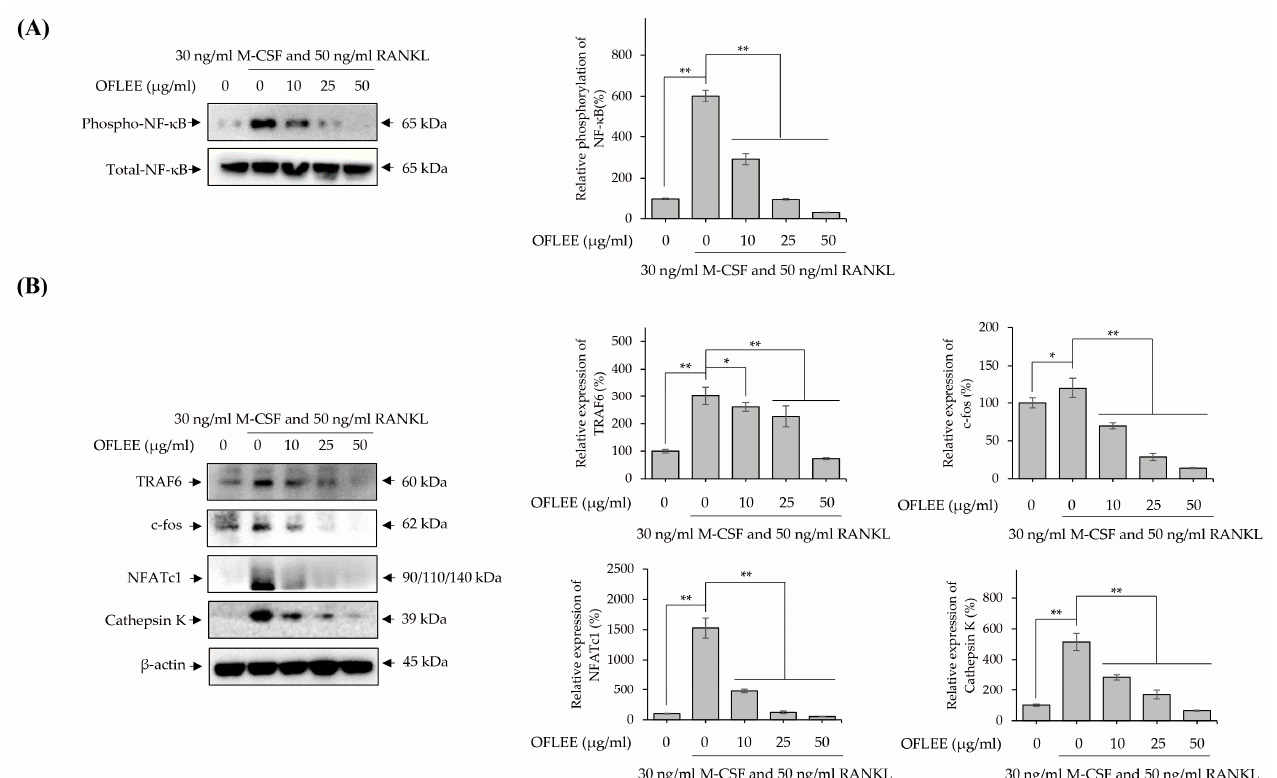
Figure 4. OFLEE suppresses the M-CSF and RANKL-induced osteoclastogenesis via the inhibition of TRAF6, NF- κ B phosphorylation, c-fos, NFATc1, and cathepsin K in BMMs. BMMs were treated with 0, 10, 25, and 50 μ g/mL OFLEE in the presence of 30 ng/mL M-CSF and 50 ng/mL RANKL for 72 h. Thereafter, Western blot was performed to verify the expression of TRAF6, NF- κ B phosphorylation, c-fos, NFATc1, and cathepsin K. β -actin was used as internal control. ( A ) OFLEE suppressed the M-CSF and RANKL-induced NF- κ B phosphorylation in BMMs. ( B ) OFLEE downregulated the osteoclastogenesis related transcriptional factors such as TRAF6, c-fos, NFATc1, and cathepsin K in the BMMs treated with M-CSF and RANKL. Results are mean ± SD of three independent experiments (n = 3), * p < 0.05 and ** p < 0.01.